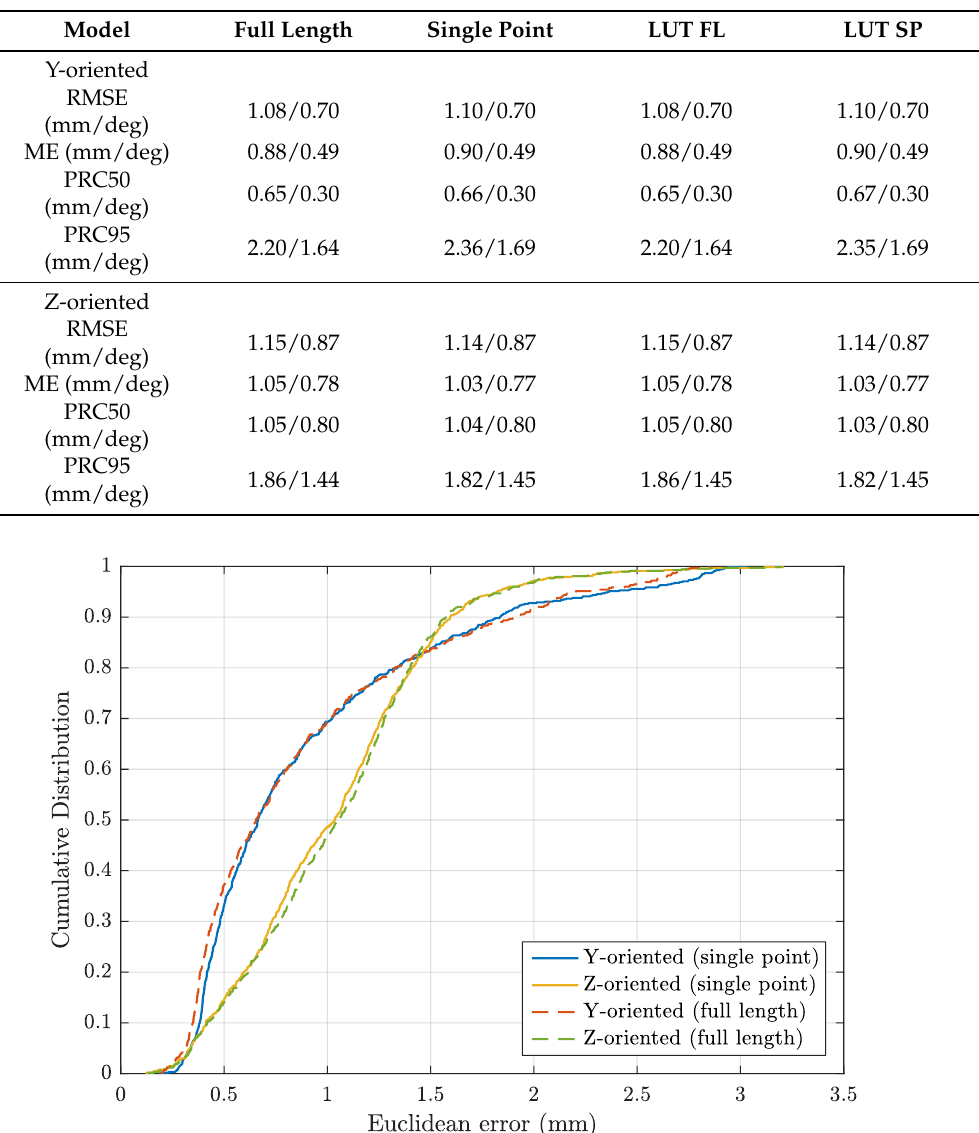
Figure 6. Empirical cumulative distribution function of the Euclidean error obtained in a real electromagnetic tracking experiment where the full-length and the single-point analytical models were used to find the sensor position and orientation. The two associated tabulated models are not shown because their results are almost coincident. The average errors for the four models are reported in Table